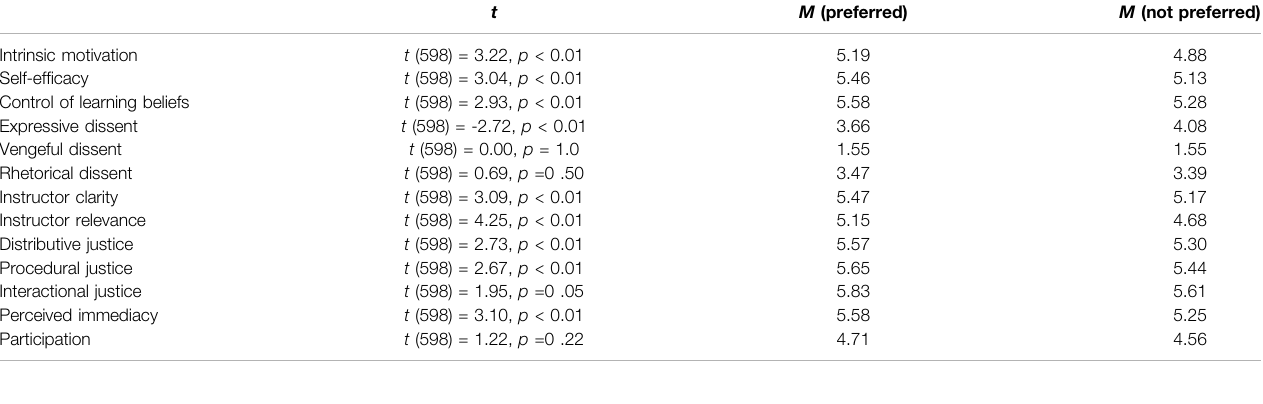
TABLE 5 | Independent Samples t -Test.